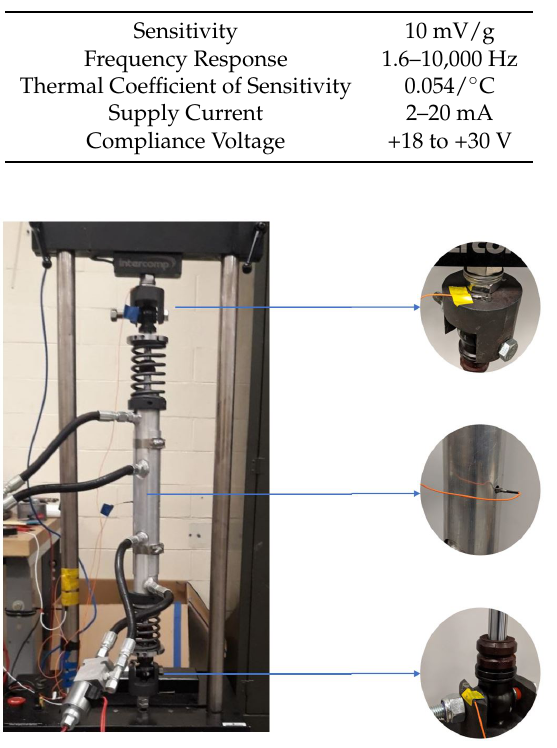
Figure 5. Double Damper with Three Single Axis Accelerometers.